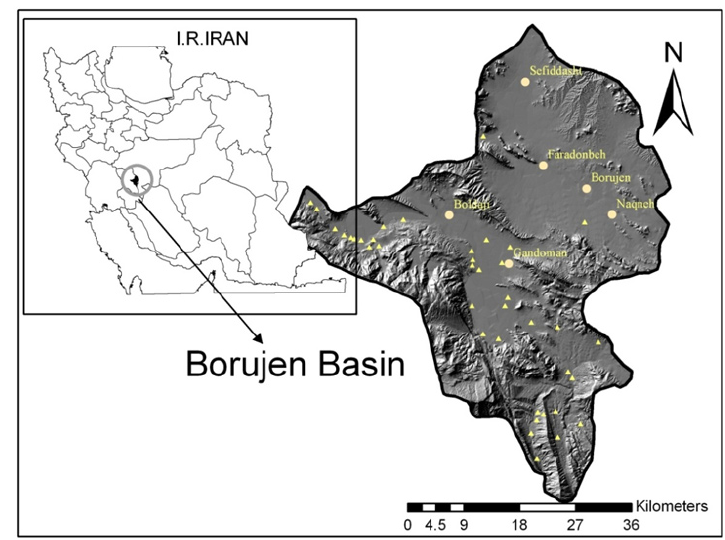
Fig 1. Location of Borujen basin in Chahar Mahaal and Bakhtiari,